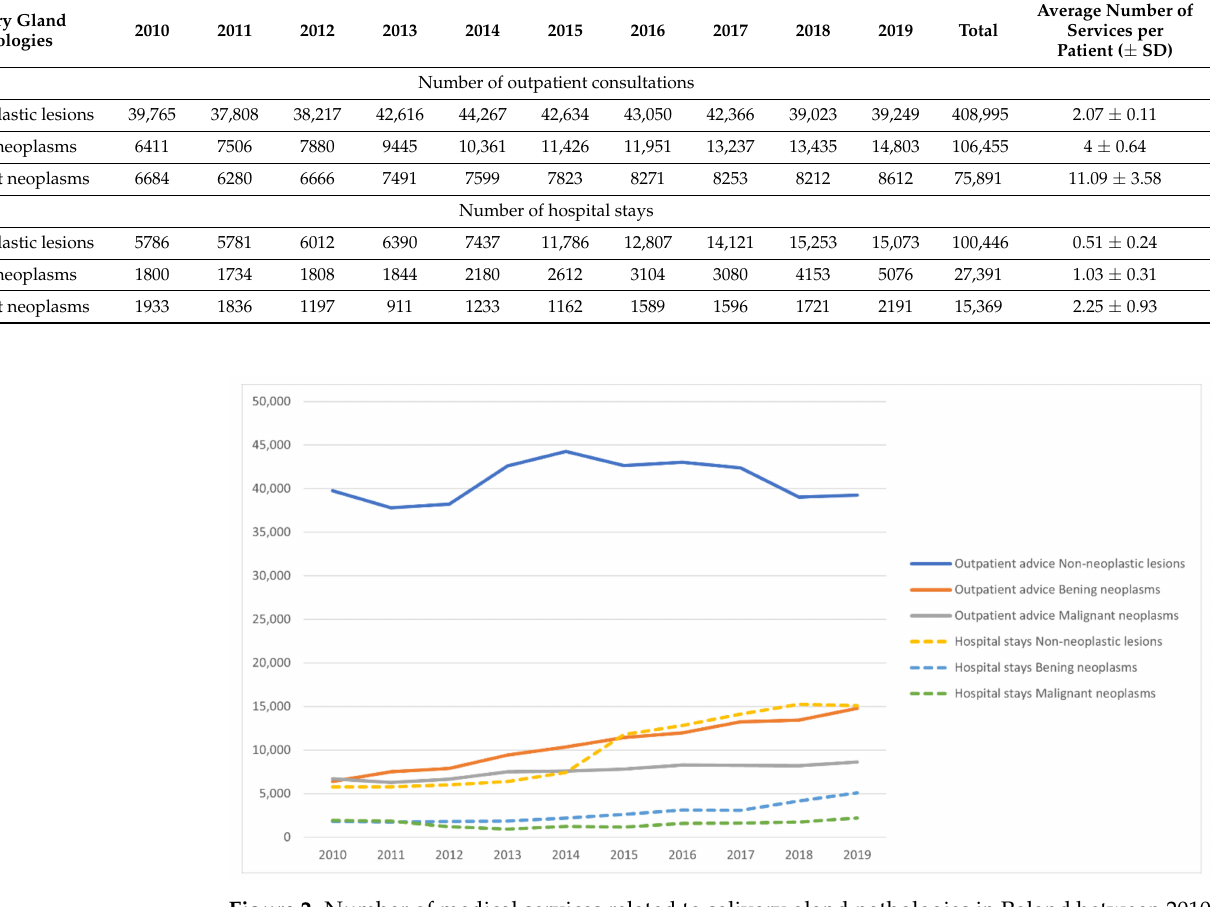
Figure 2. Number of medical services related to salivary gland pathologies in Poland between 2010 and